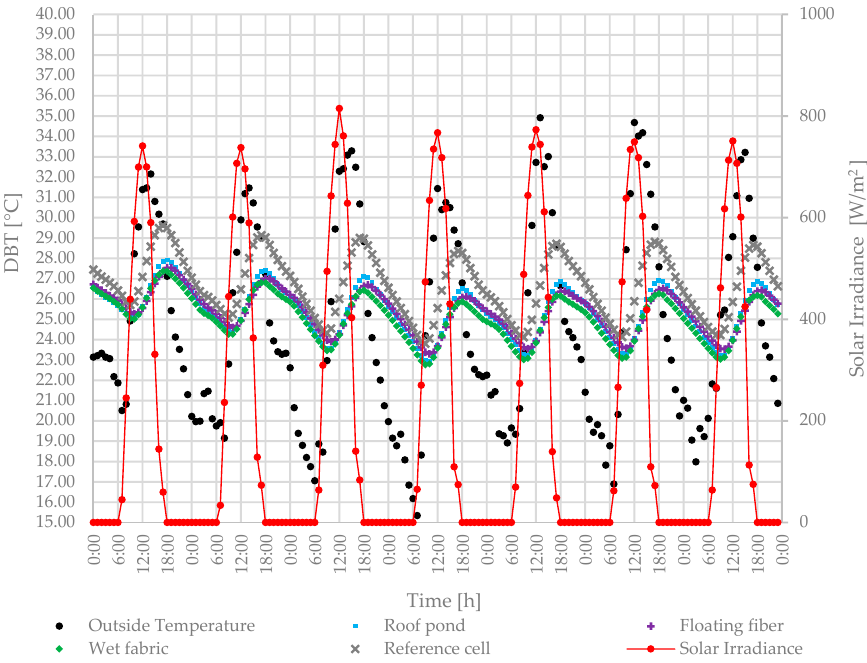
Figure 9. Comparison of the indoor air temperatures in the warm sub ‐ humid season.